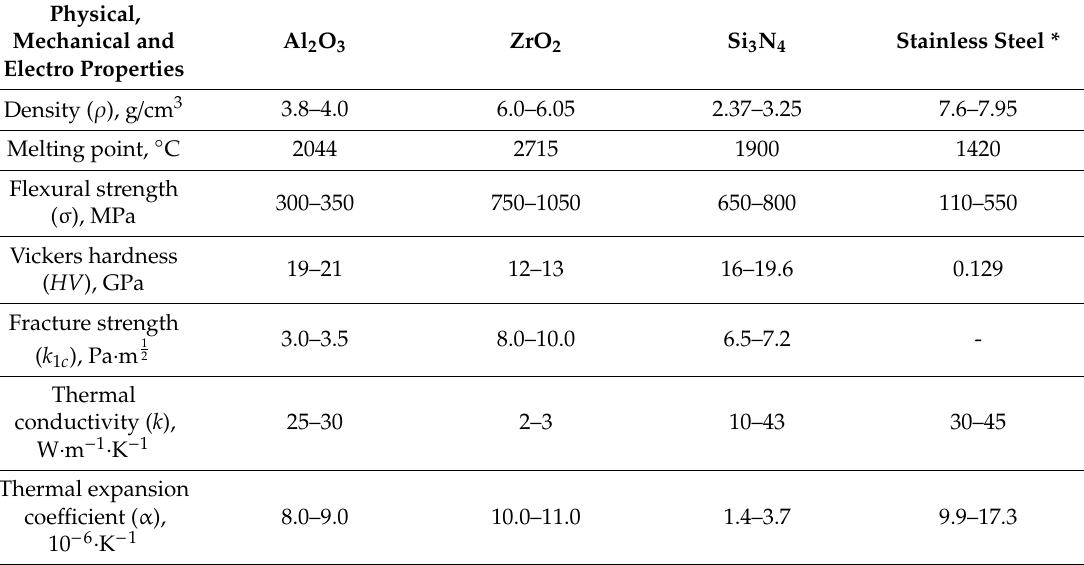
Figure 5. The relationship of the basic physical and mechanical parameters for some materials. Table 1. The main properties of some materials